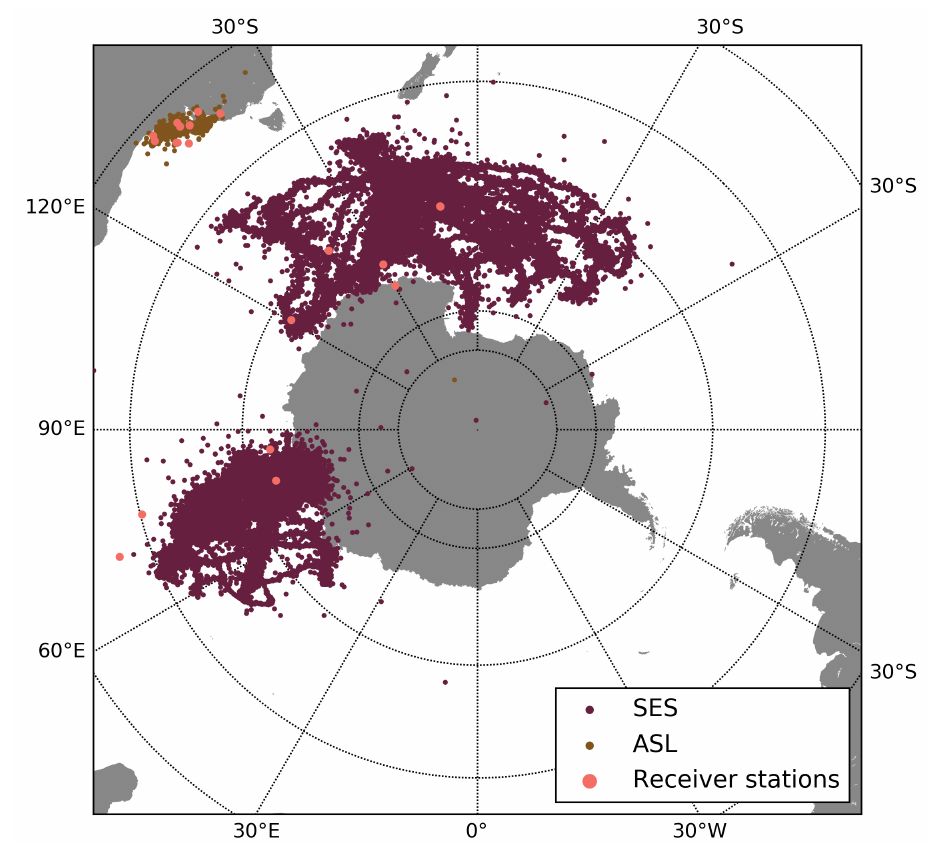
Figure 8. Trajectories of southern elephant seals (violet) and Australian sea lions (brown) tracked during the years 2010–2012. We also included 10 receiver stations randomly distributed for each species (pink